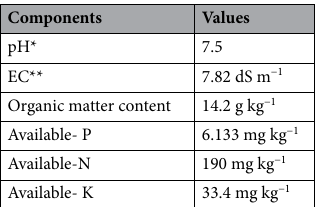
Table 1. Soil component analysis. *pH was determined in 1:2.5 (soil:water) suspension, **EC was determined in soil paste